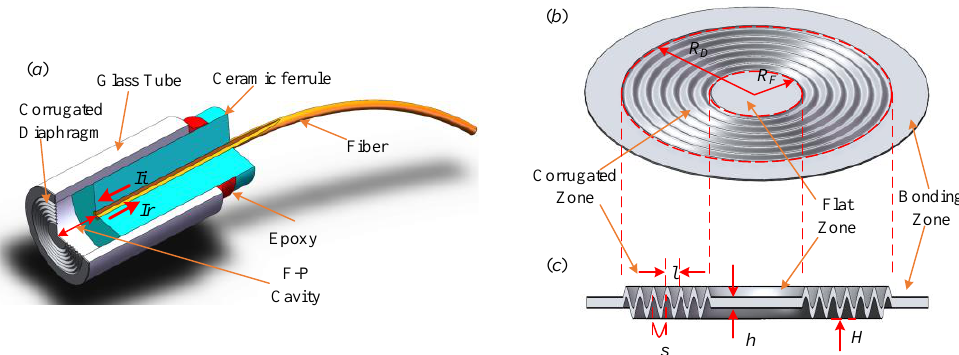
Figure 12. Schematic of the proposed OFM based on CD. ( a ) Schematic diagram of the proposed OFM; ( b ) Schematic, and ( c ) section diagram of the CD. (Reproduced from [26]).